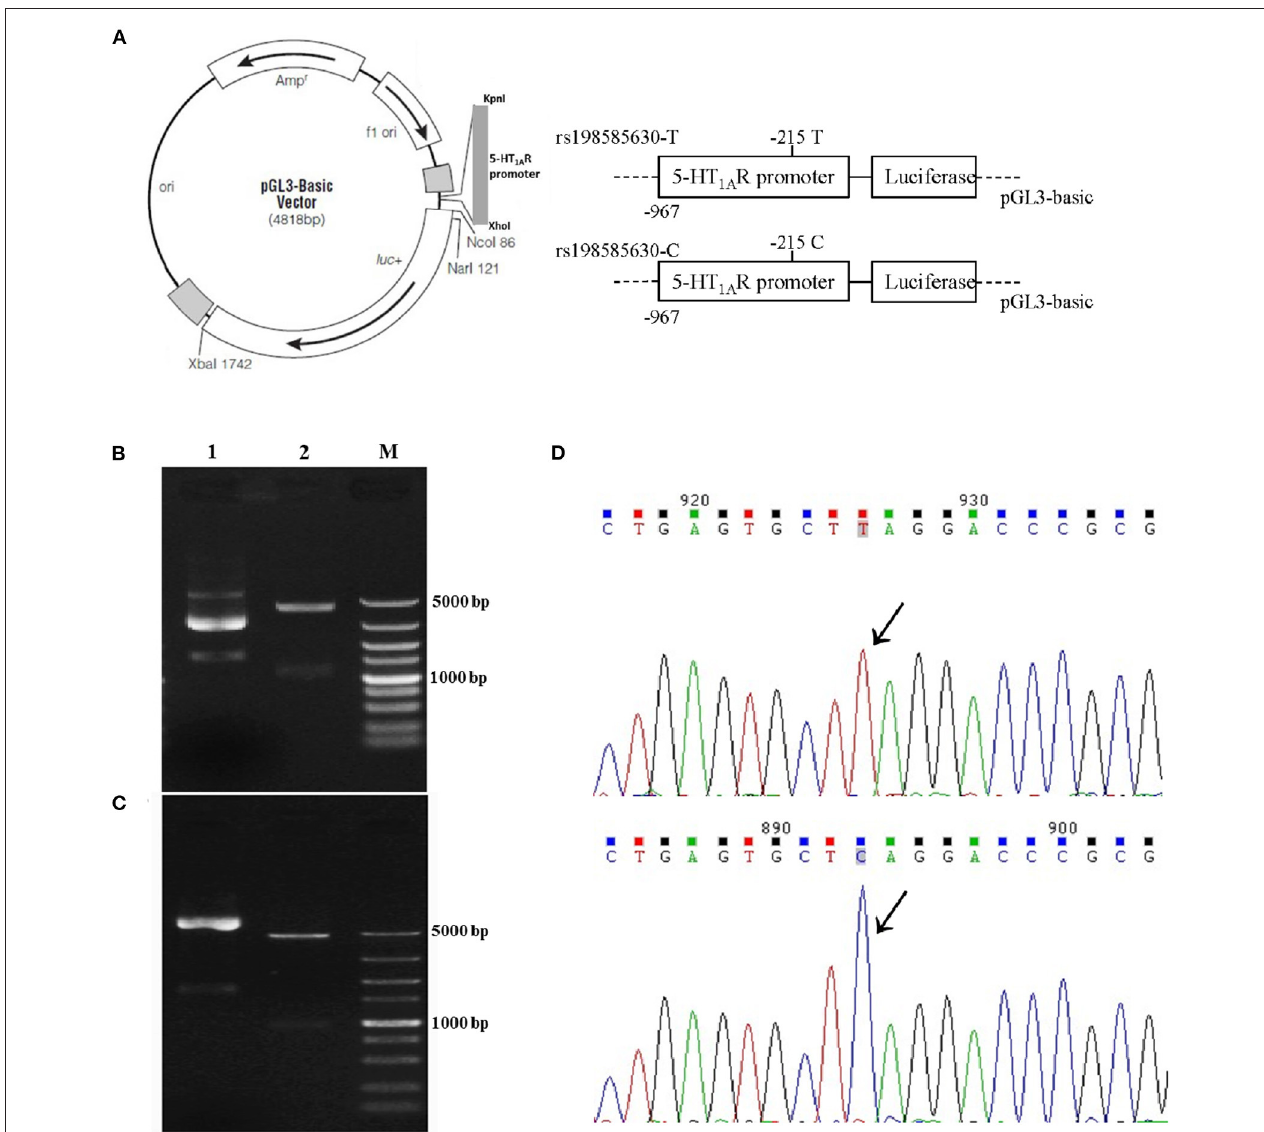
FIGURE 1 | Recombinant reporter plasmids carrying the 5-HT 1A receptor rs198585630T and C alleles. (A) The recombinant reporter plasmids. (B,C) Results of double digestion of the 5-HT 1A receptor promoter containing the − 215T allele (B) and C allele (C) in the pGL3-basic vector. Lane 1: Undigested fragment; lane